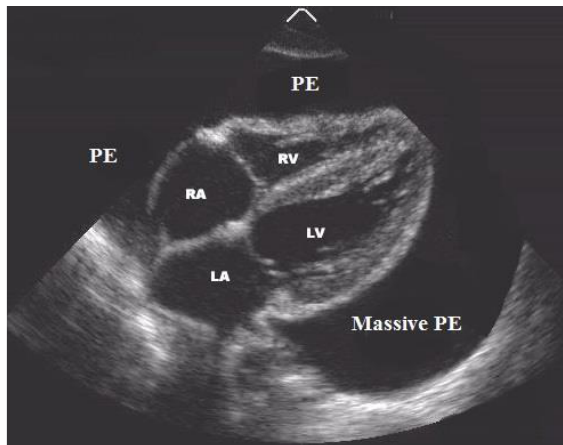
Figure 2 . Echocardiography before